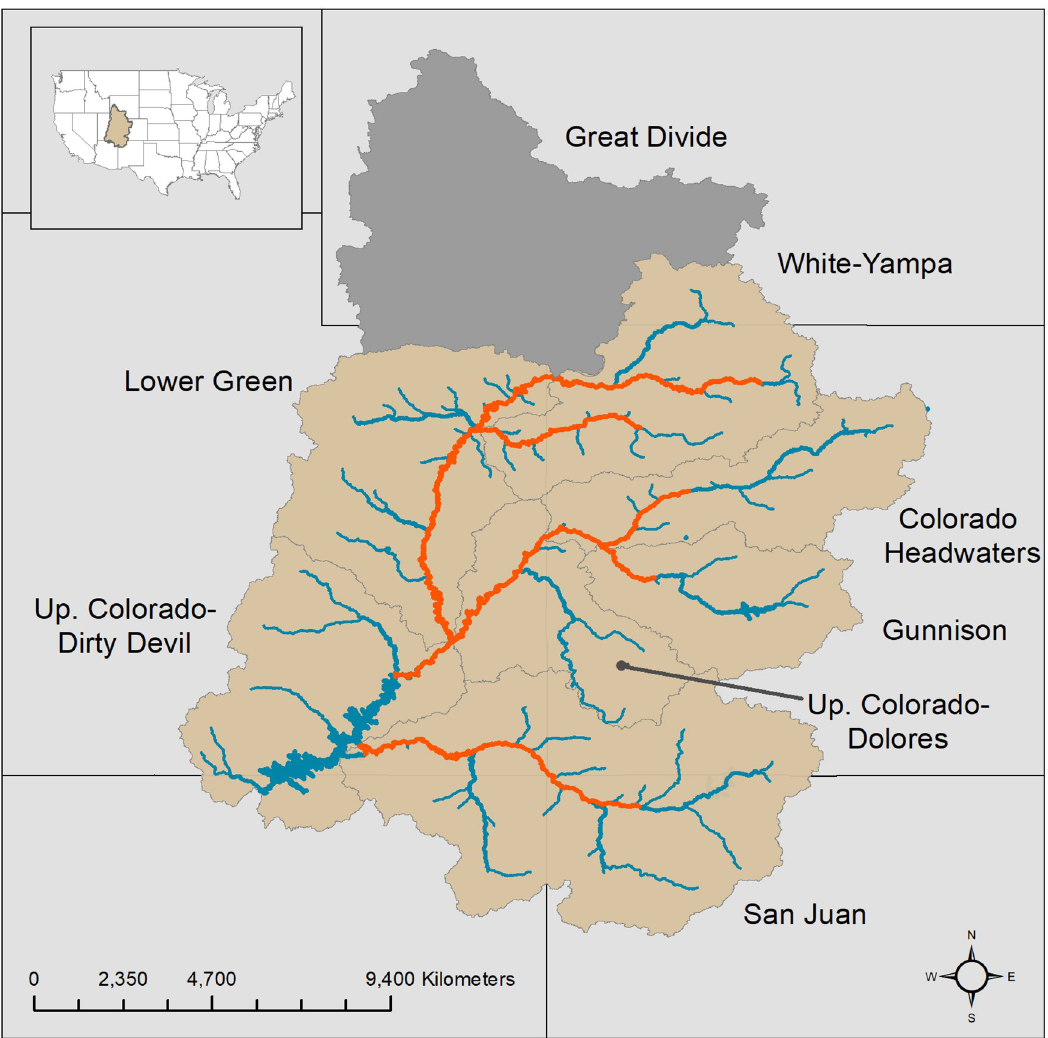
Fig 1. The Upper Colorado River Basin spans 5 states and is comprised of 8 tributaries, including the Colorado Headwaters, Gunnison, Upper Colorado-Dolores, White-Yampa, Lower Green, Upper Colorado-Dirty Devil, and the San Juan. We did not include data within the Great Divide- Upper Green tributary (shaded grey) above Flaming Gorge Dam as it is disconnected from the rest of the UCRB. River shaded orange is critical habitat for the federally endangered Colorado